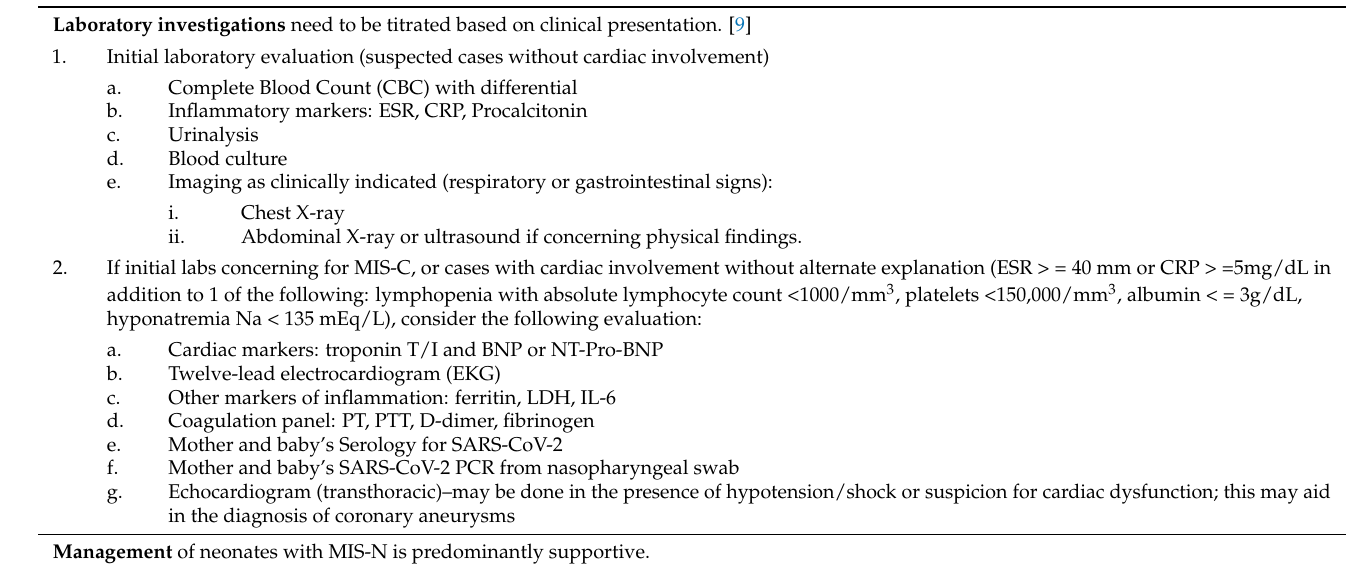
Table 4. Protocol for laboratory investigations and management of